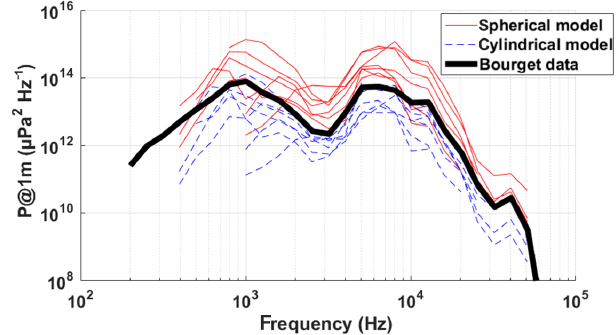
Figure 7. Power spectral density of the source power ( P @1m in µPa 2 Hz − 1 ) estimated with spherical and cylindrical models for all experiments made in rivers and measured in Lac du